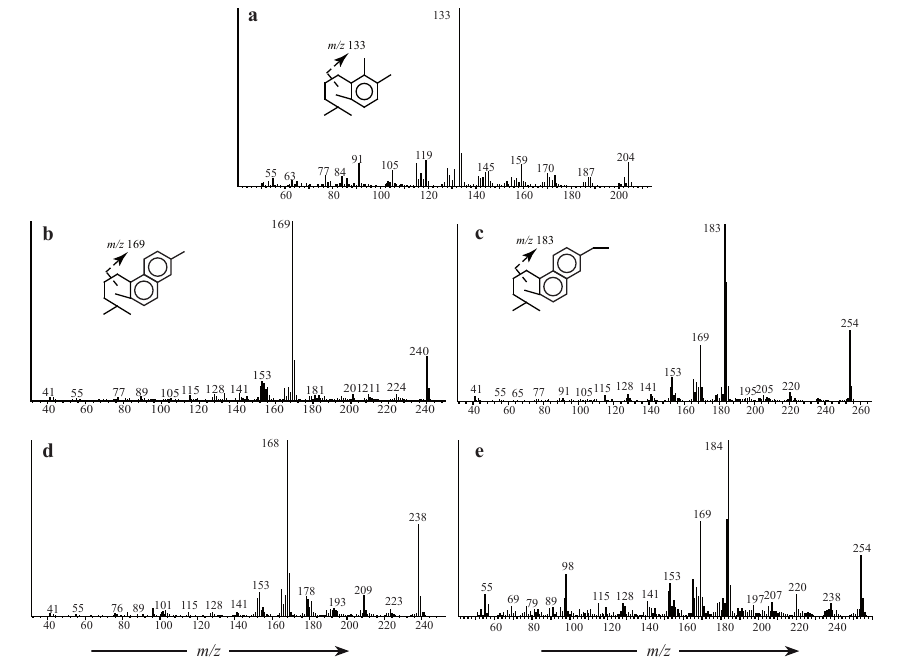
Fig. 5. Mass spectra of identified isohexyl alkylaromatic hydrocarbons in Araucariaceae species and mass spectral cleavage patterns (identi- fied after Ellis et al., 1996). (a) : 1,3,4-trimethyl-2-(4-methylpentyl)benzene; (b) : 2,6-dimethyl-1-(4-methylpentyl)- naphthalene; (c) : 6-ethyl- 2-dimethyl-1-(4-methylpentyl)-naphthalenemethylretene. Mass spectra of some unidentified Araucariaceae diterpenoids, but similar to some of the identified isohexyl alkylaromatic hydrocarbons: (d) to (b) and (e) to (c). Table 4. Major sesquiterpenoids and diterpenoids classes detected in Araucariaceae species after confined pyrolysis with (saturated com- pounds) and without (aromatic compounds) LiAlH 4 as reducing